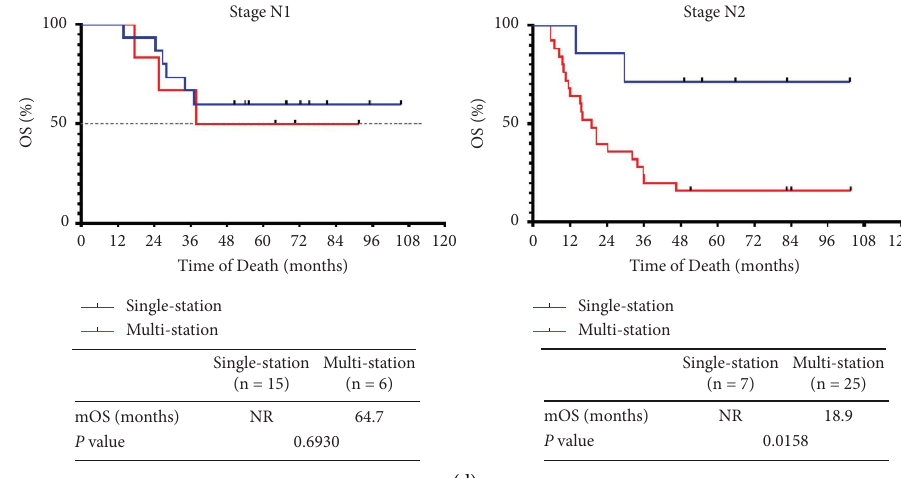
Figure 3: Prognostic utility of lymph node involvement by N stage in patients with resected LS SCLC. (a) Te DFS curves of resected SCLC patients with stage pN1 ( n � 23) and pN2 ( n � 36) by the number of involved lymph nodes. (b) Te survival curves of resected SCLC patients with stage pN1 ( n � 23) and pN2 ( n � 36) by the number of involved lymph nodes. (c) Te DFS curves of resected SCLC patients with stage pN1 ( n � 23) and pN2 ( n � 36) by the numbers of involved lymph node stations. (d) Te survival curves of resected SCLC patients with stage pN1 ( n � 23) and pN2 ( n � 36) by the number of involved lymph node stations.